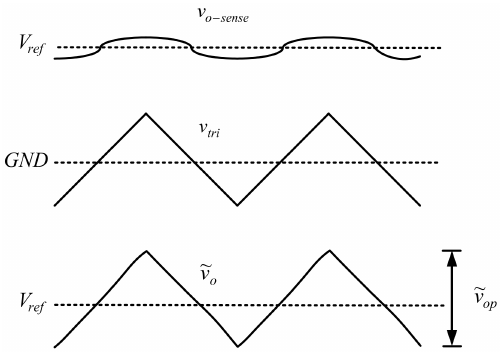
Figure 15. Waveforms before and after triangular wave